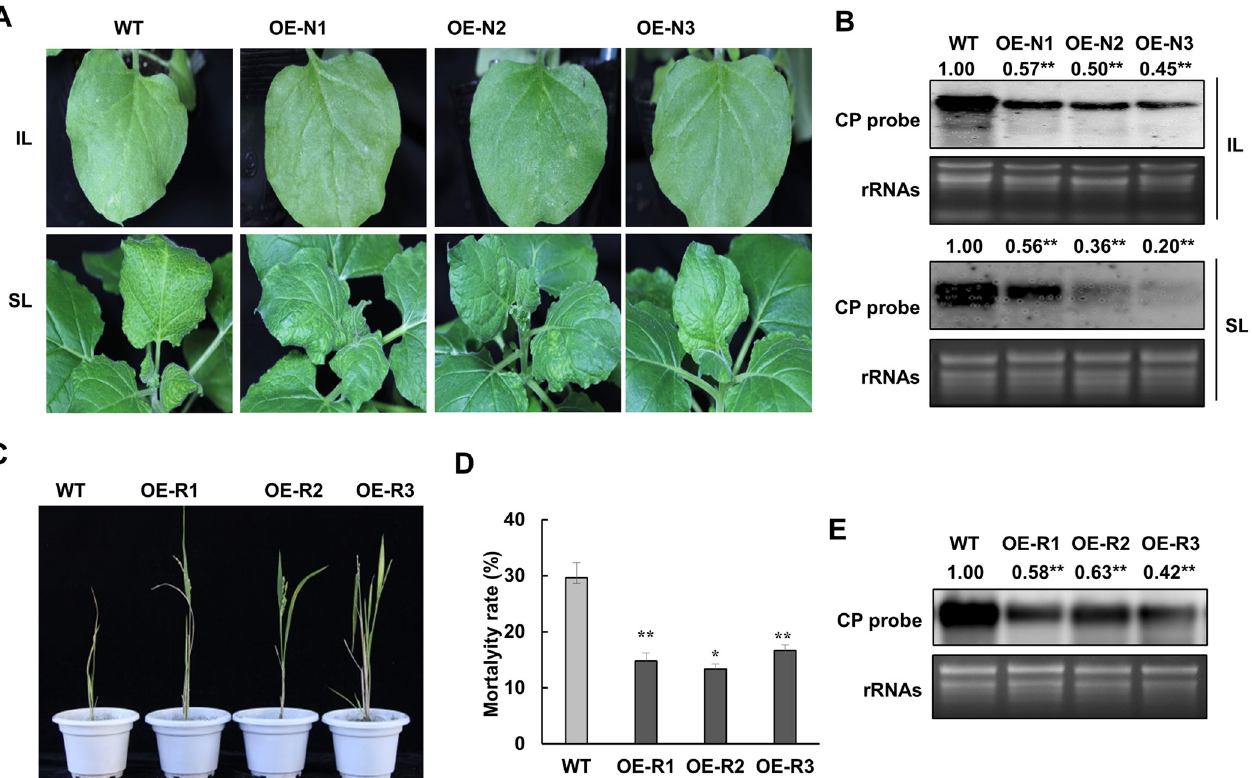
Fig 7. RSV infection is inhibited in plants overexpressing UBL5 . A. N . benthamiana wild type and three transgenic lines (OE-N1, OE-N2 and OE-N3) overexpressing NbUBL5 . 1 were inoculated with RSV. At 7 dpi, wild-type plants showed typical yellow foci on the inoculated leaves, while no obvious infection foci appeared on leaves of transgenic plants. At 15 dpi, all wild-type plants showed typical mosaic and chlorosis on newly-emerged leaves, implying systemic infection with RSV, but on transgenic plants the systemic symptom was significantly alleviated. B. Northern blot showing that RSV RNAs accumulated at a lower level in both the inoculated and systemically infected leaves of transgenic lines. C. Wild type rice and three transgenic lines (OE-R1, OE-R2 and OE-R3) overexpressing OsUBL5 were inoculated with RSV. At 20 dpi, approximately 40% of the wild type plants were dead, while only about 25% transgenic plants had died. D. In the surviving plants, RSV symptoms on transgenic plants were significantly milder with fewer yellow streaks than on wild type plants. E. In the surviving plants, the accumulation of RSV RNAs was also less than on transgenic plants. Twenty plants were used for each of three biological repeats. Bars represent the standard errors of the means from three biological repeats. Band intensity in blots was calculated by ImageJ based on three replicates. A two- sample unequal variance directional t test was used to test the significance of the difference ( �� , p value <